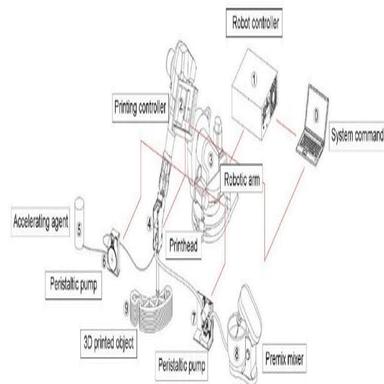
Typical 3DCP experimental setups. (a) TU Delft: 3-axis gantry-based system, multiple batches (material preparation), and rotor-stator-based pump, adapted from Ref. ; (b) TU Eindhoven: 4-axis gantry-based system, continuous mixing (material preparation), and rotor-stator-based pump, adapted from Ref.; (c) XtreeE: 6-axis robotic arm, peristaltic pump, and inline mixing and extrusion printhead (set-on-demand), adapted from Ref.; (d) TU Dresden: 4-axis gantry-based system, multiple b